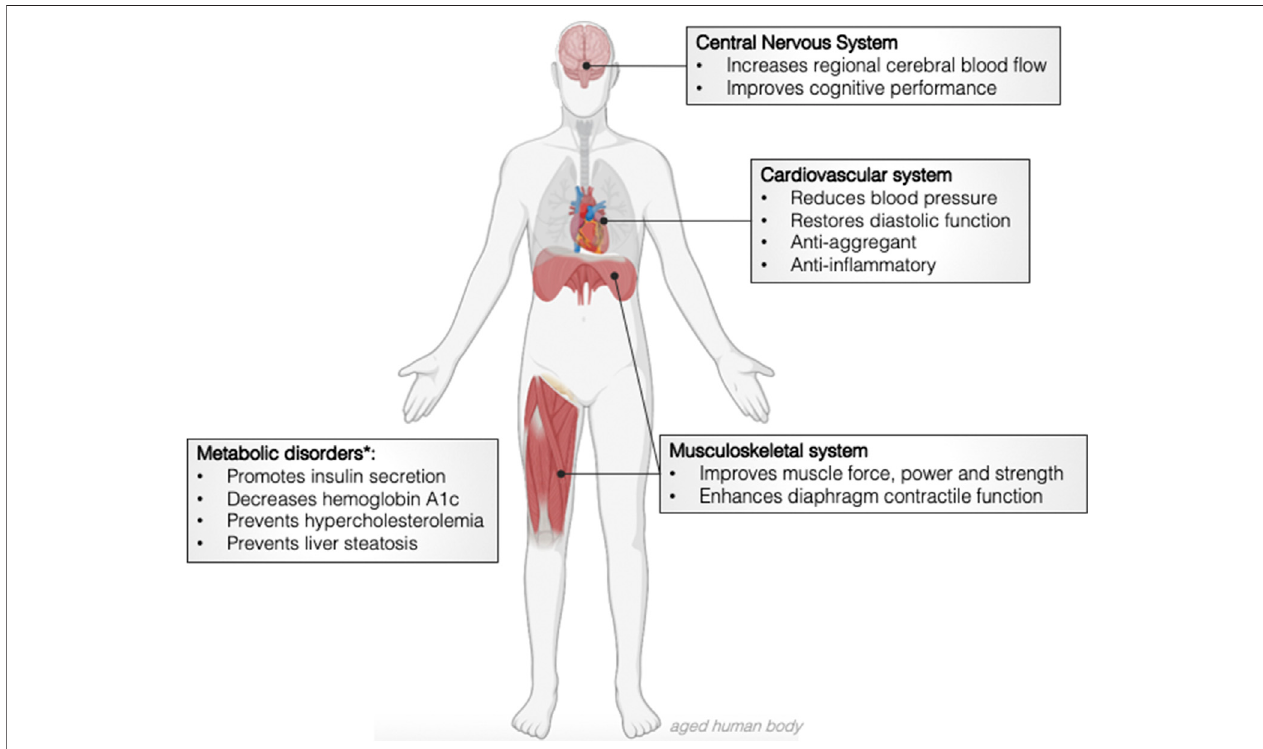
FIGURE 1 | Effects of dietary nitrate in the physiological events associated with healthy ageing and age-related disorders. *pre-clinical and clinical data obtained from middle age and old volunteers.